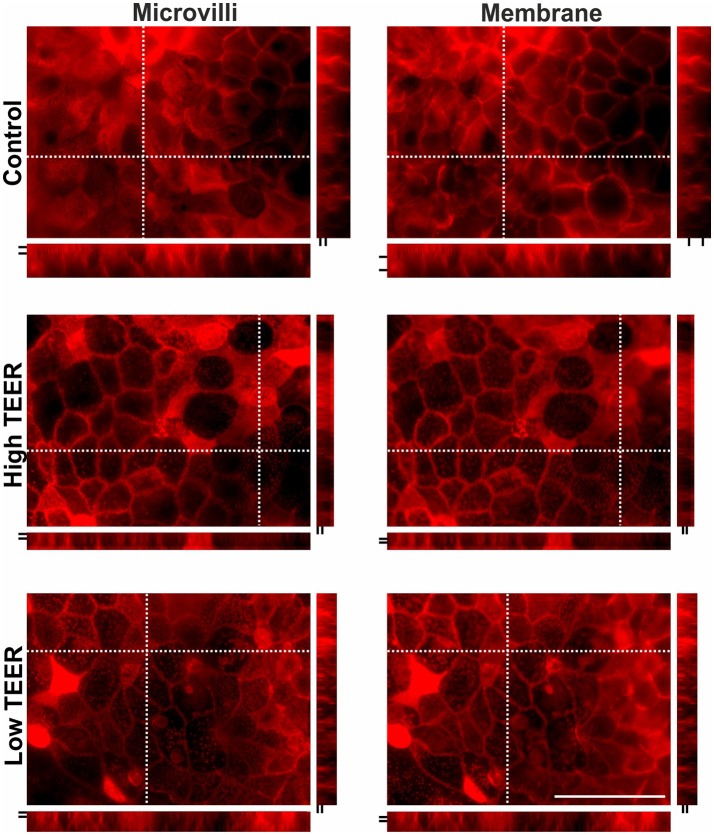
Actin protein staining in differentiated Caco-2 cell monolayers upon PA treatment. Fourteen-days differentiated Caco-2 monolayers grown in DMEM-galactose were incubated with vehicle (96% EtOH, control) or 200 nM Piericidin A (PA), after which actin immunofluorescent staining was performed. Changes in protein distribution reflecting microvilli length and membrane structure were analyzed in maximal intensity images created from 15 to 20 steps in regions where membrane stainings were most obvious at the moments that the transepithelial resistance (TEER) of the monolayer was high (High TEER) and low (Low TEER). Dashed crossed line in the XY images marks the position of the XZ (below the XY image) and YZ (right side of XY image) side views. The space between the two short black lines in the XZ and YZ side views represent thickness of microvilli and relative membrane thickness, respectively. Scale bar represents 50 μm.